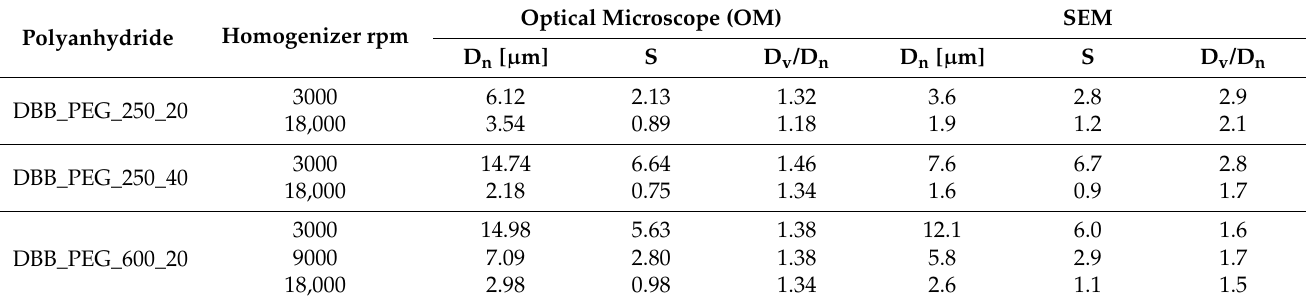
Table 4. Size and size distribution of microspheres calculated from optical microscope and SEM images. Polyanhydride